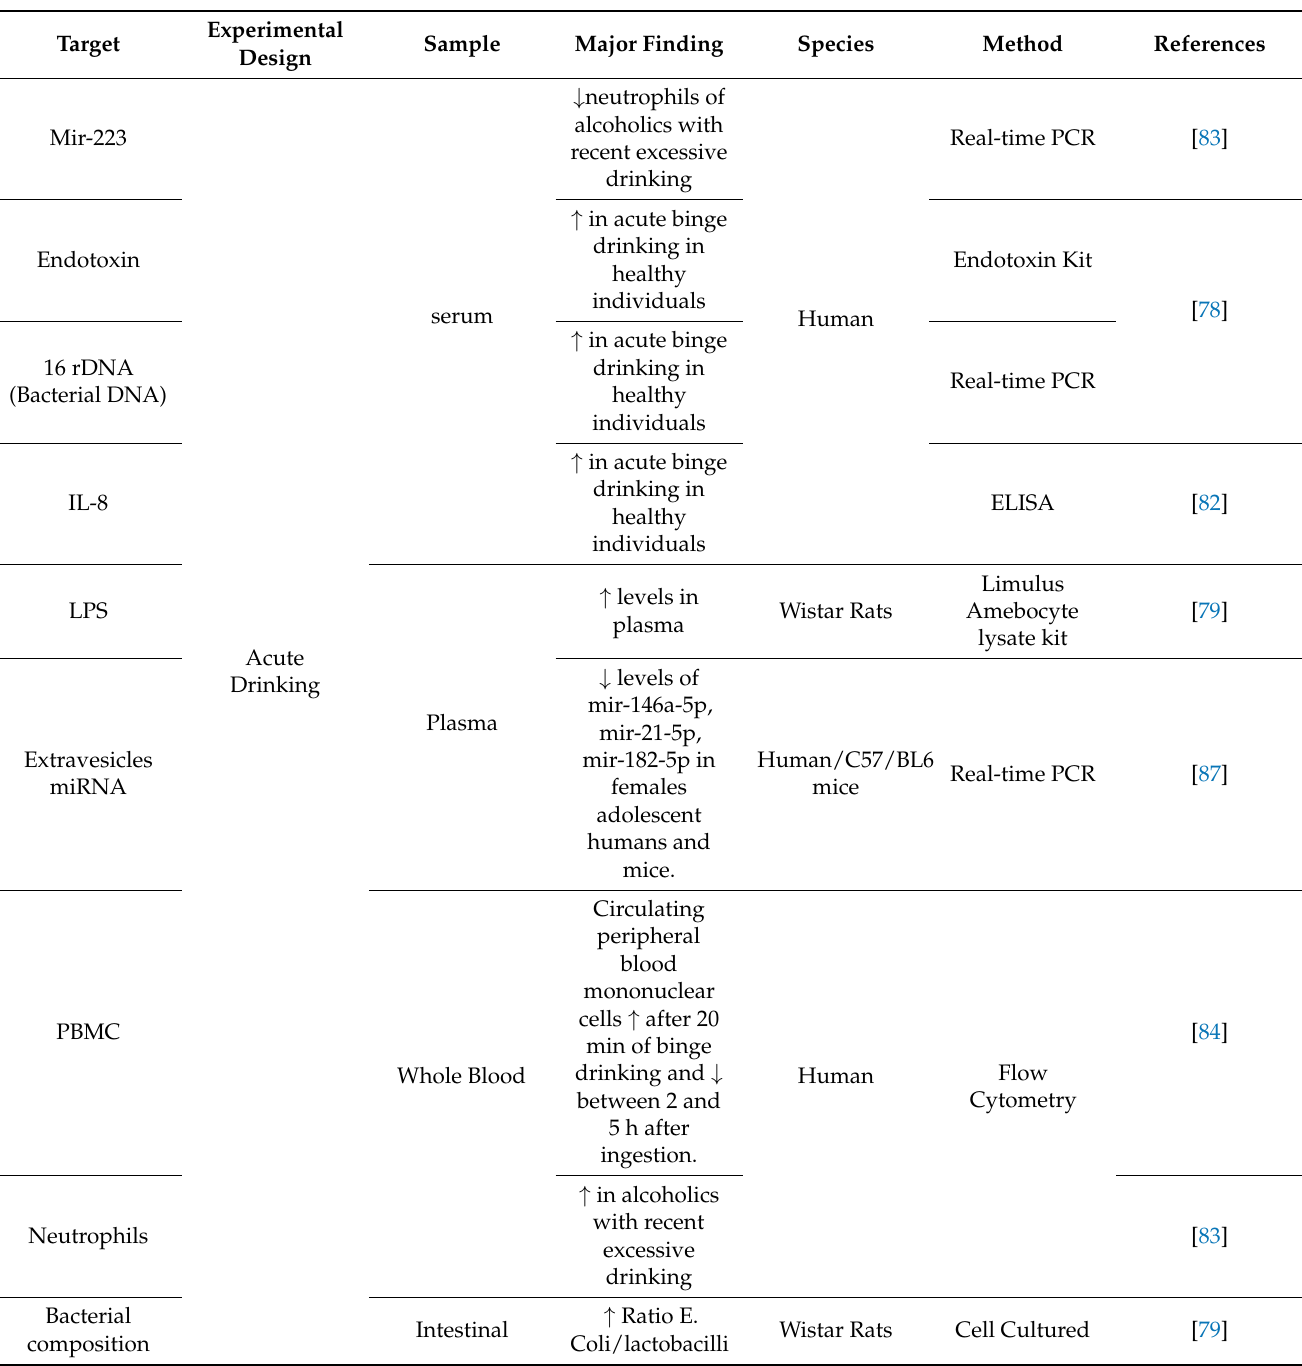
Table 2. Alcohol use disorder: Acute